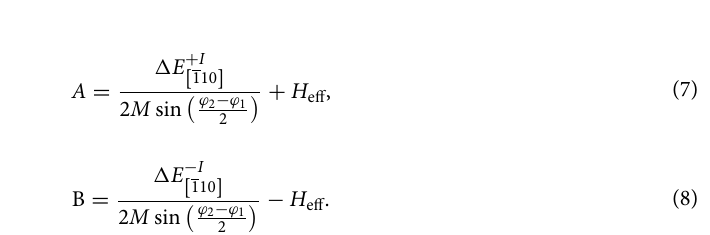
± I The values of sin ϕ H and H SW in Eqs. (5) and (6) can be obtained from field scans of PHR carried out at dif- ferent field directions, as shown in Fig. 3. For the fitting, we use average switching fields for the assisted and hindered cases, respec- tively, from the negative and positive field regions in Fig. 3. The values of